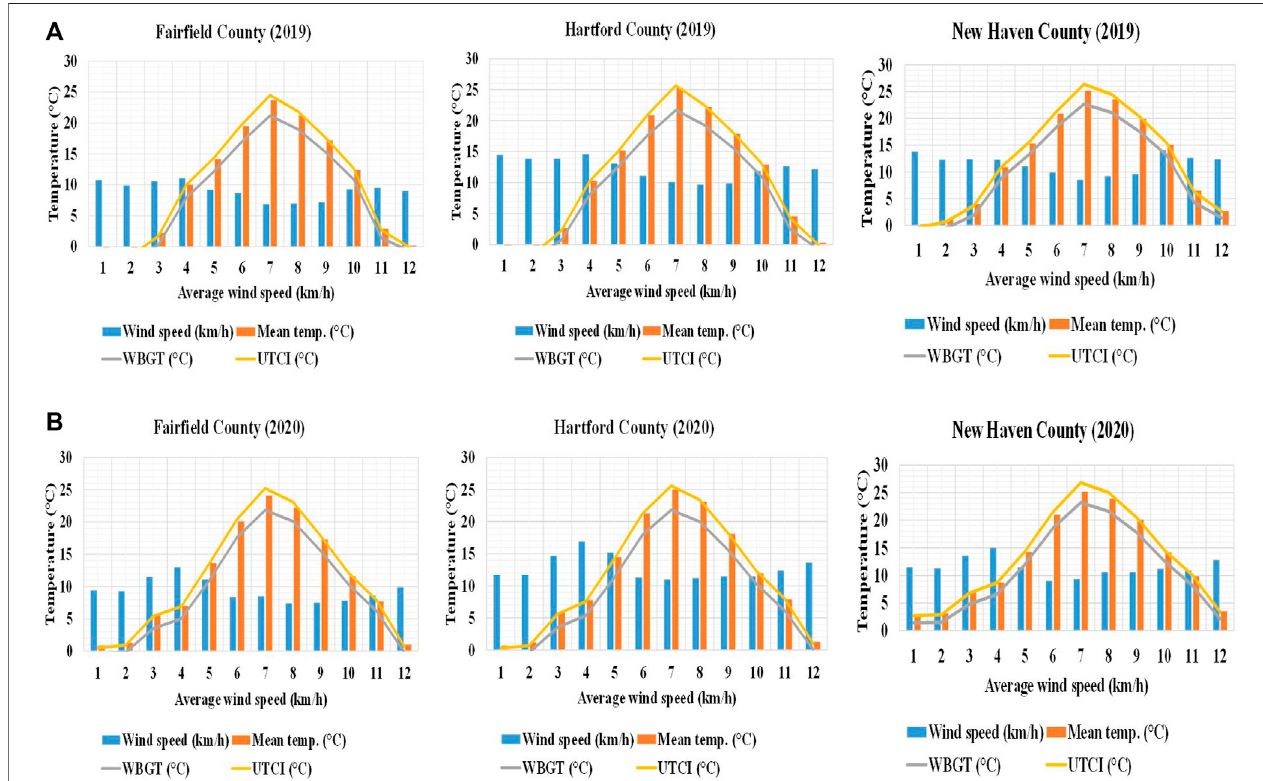
FIGURE11|(A) :Relationshipsbetweenaveragewindspeed,meantemperatures,andthermalindicesinFair fi eld (left) ,Hartford (middle) ,andNewHaven (right) in 2019 (pre-pandemic year). (B) : Relationships between average wind speed, mean temperatures, and thermal indices in Fair fi eld (left) , Hartford (middle) , and New Haven (right) in 2020 (pandemic year).